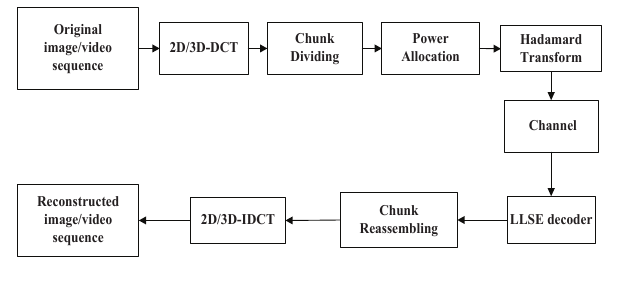
Figure 1: Framework of SoftCast.